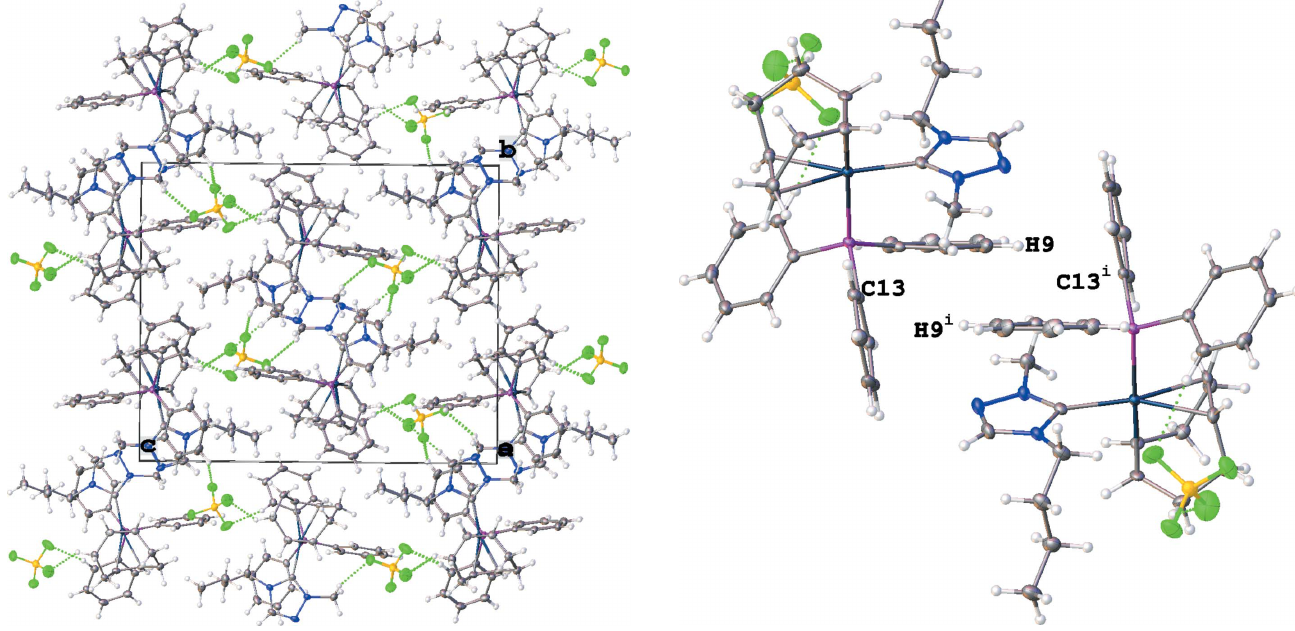
Figure 2 Crystal packing unit-cell diagram of the title compound ( 4 ) shown along the a axis. Hydrogen-bonding interactions between F and H atoms are shown as dotted green lines. Add axis labels